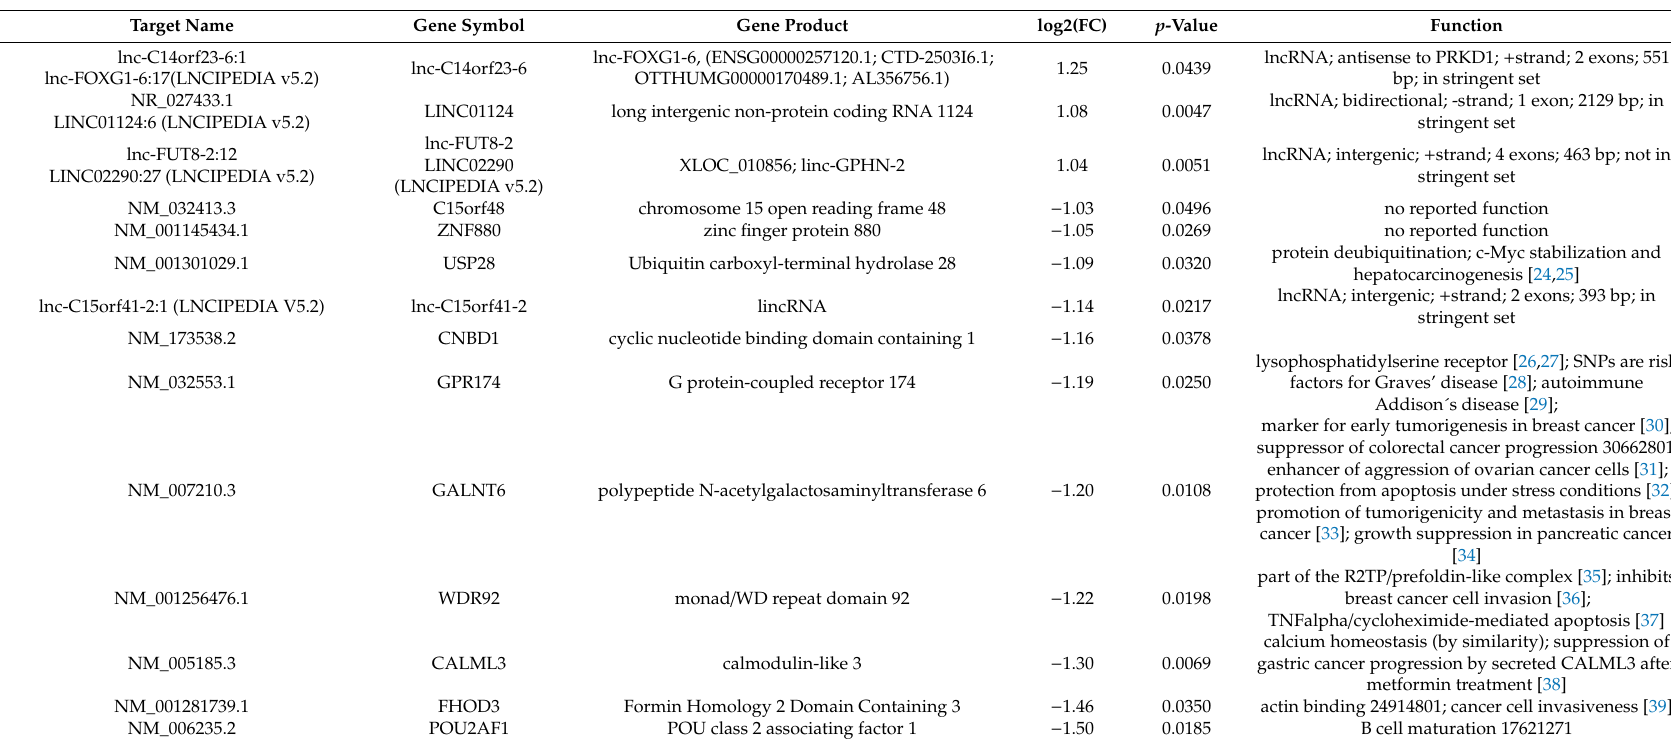
Table 1. Genes significantly changed between CCF (clear cell foci) and unaltered liver tissue (at least 2-fold up / down, CCF vs. control; p -value ≤